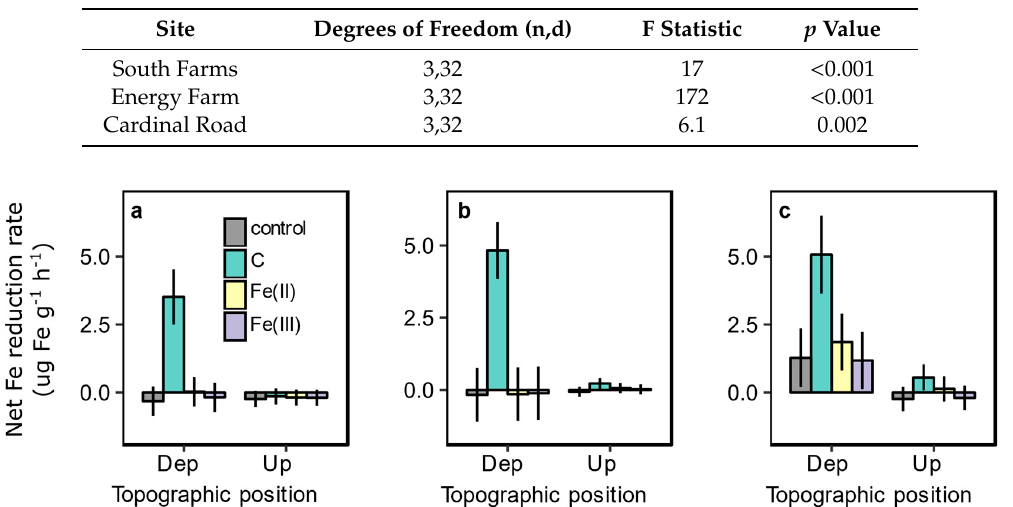
Table 3. Results from ANOVAs explaining variation in soil Fe reduction rates during the late season lab experiment.